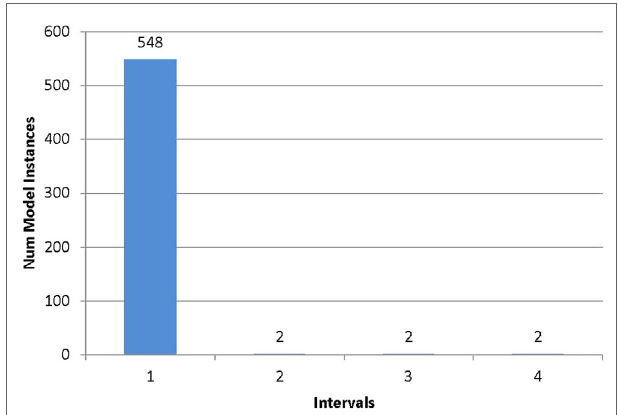
FigUre 3 | Frequency histogram for location 84 . The prediction range at this location is divided into intervals of equal width according to the estimate of error threshold. The horizontal axis represents the interval number and the vertical axis the number of models lying in the interval.